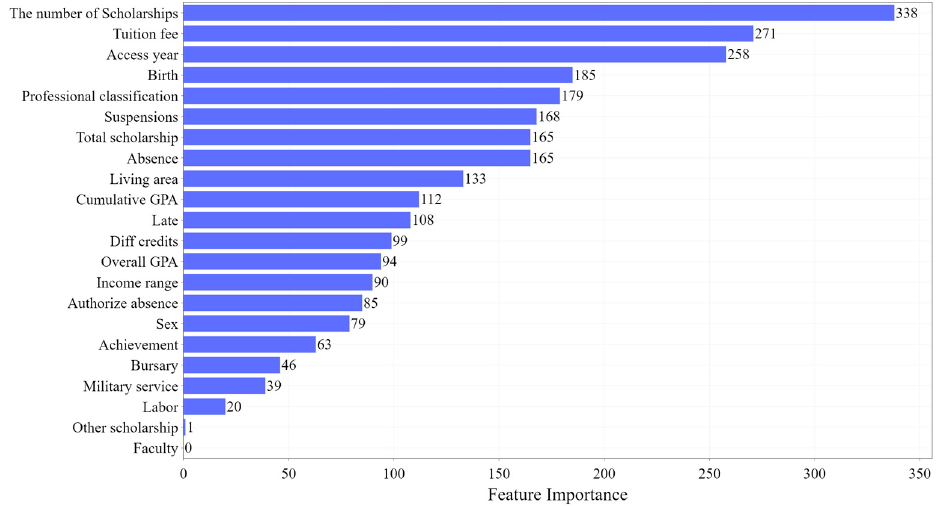
Figure 4. Feature Importance of LightGBM Model trained in the mean value-based feature table.